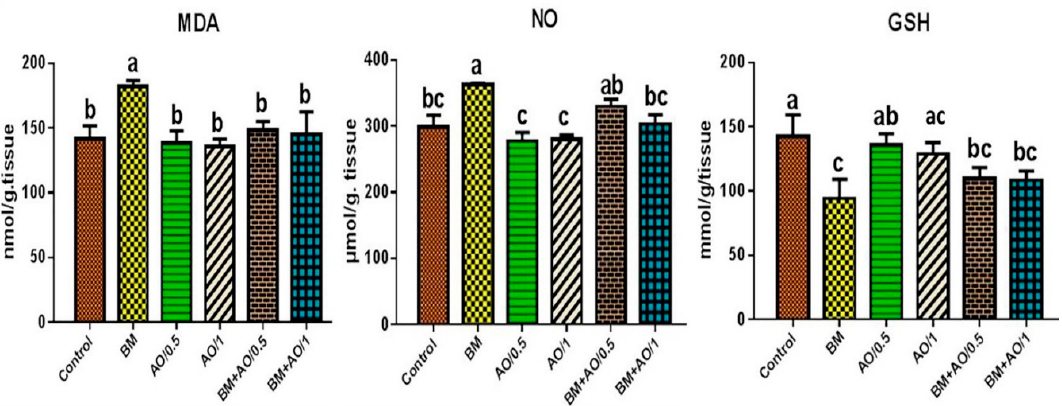
Figure 2. Effect of betamethasone and/or argan oil on renal oxidant/antioxidant biomarkers different treated groups ( n = 8). Different letters (a,b,c) indicate significant differences at p < 0.05. BM: betamethasone, AO: argan oil, MDA: malondialdehyde, NO: nitric oxide, GSH: reduced glutathione.